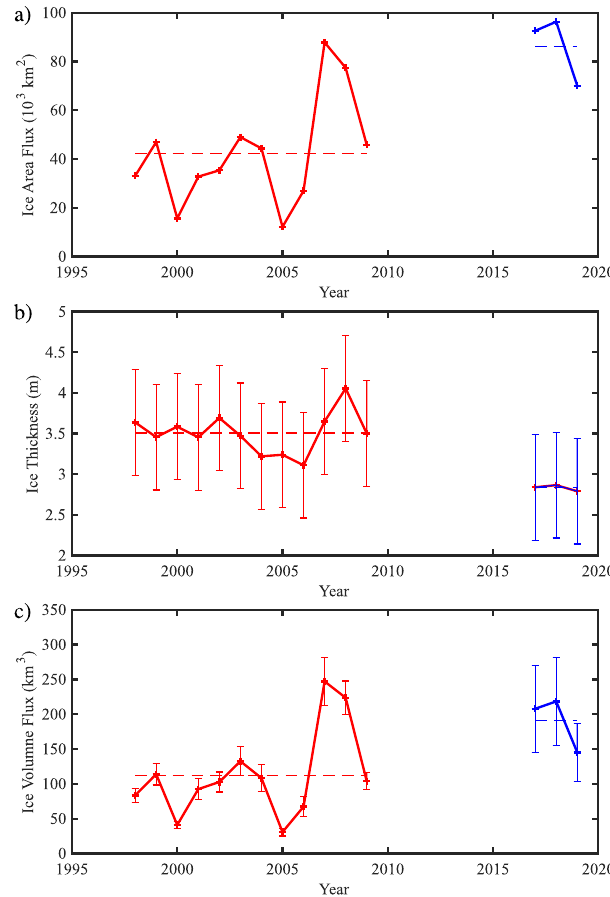
Fig. 8 The changing nature of the ice fl ux through Nares Strait. a The annual mean ice area fl ux (103 km 2 ) through the southern Lincoln Sea fl ux gate. b The annual mean sea ice thickness (m) over the southern Lincoln Sea estimated from PIOMAS data. c The annual mean ice volume fl ux (km 3 ) through the southern Lincoln Sea fl ux gate. The data in red is from Kwok et al study with the data in blue from this study. Means over the period of the two data sets (1997 – 2009) and (2016 – 2019) are shown with dashed lines. Annual means de fi ned from Sept 1 to Aug 31. In b and c , error bars are included based on the uncertainty in ice thickness derived from the comparison with CryoSat2 data shown in Fig. 7 (see Methods). As discussed in the Methods Section, the uncertainty in ice area fl ux is negligible on annual time